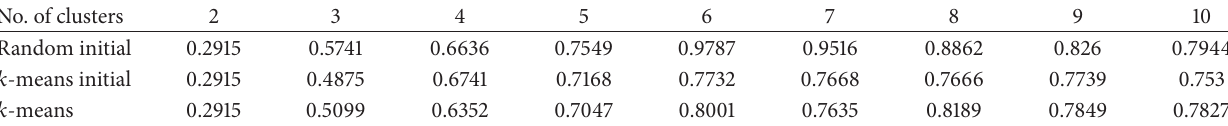
Table 1: The values of AARI for different clustering methods on synthetic data.